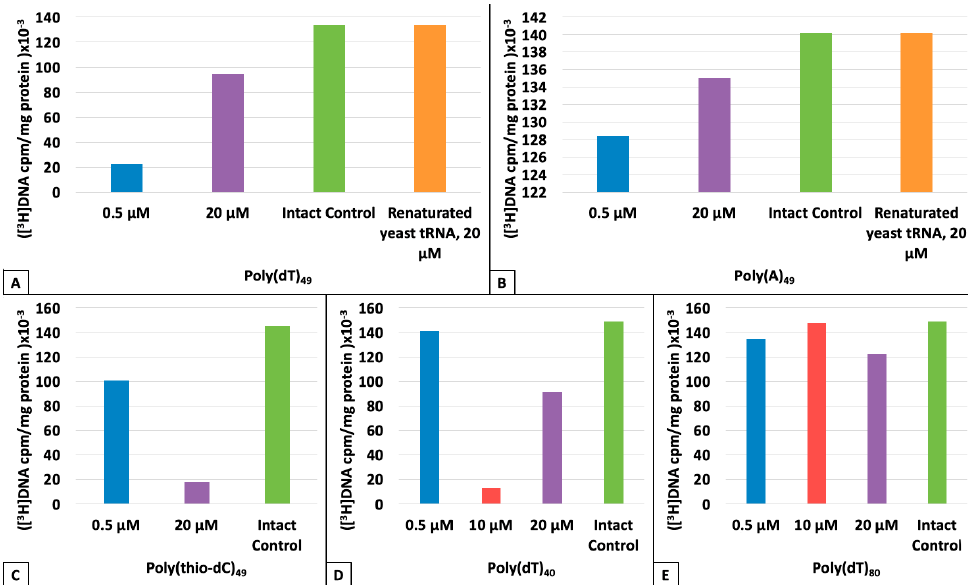
Figure 3. ( A ) Catalytic activity of AML/HL-60 beta-like DNA polymerase in the presence of Poly(dT)49 and renatured yeast tRNA. ( B ) Catalytic activity of AML/HL-60 beta-like DNA polymerase in the presence of Poly(A)49 and renatured yeast tRNA. ( C ) Catalytic activity of AML/HL-60 beta-like DNA polymerase in the presence of Poly(thio-dC)49 and renatured yeast tRNA. ( D ) Catalytic activity of AML/HL-60 beta-like DNA polymerase in the presence of Poly(dT) 40 . ( E ) Catalytic activity of AML/HL-60 beta-like DNA polymerase in the presence of Poly(dT) 80.